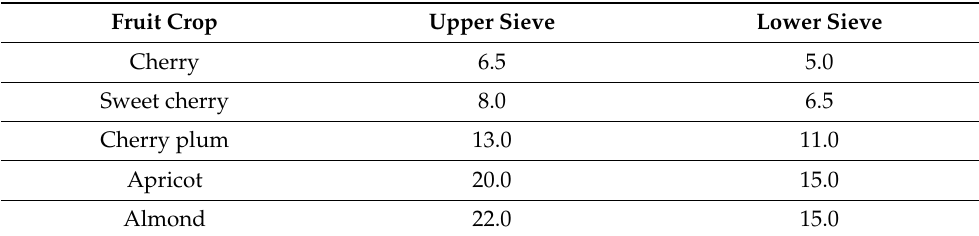
Table 1. The diameters of the openings of the sieve d, mm. Fruit Crop Upper Sieve Lower Sieve Cherry Sweet cherry Cherry